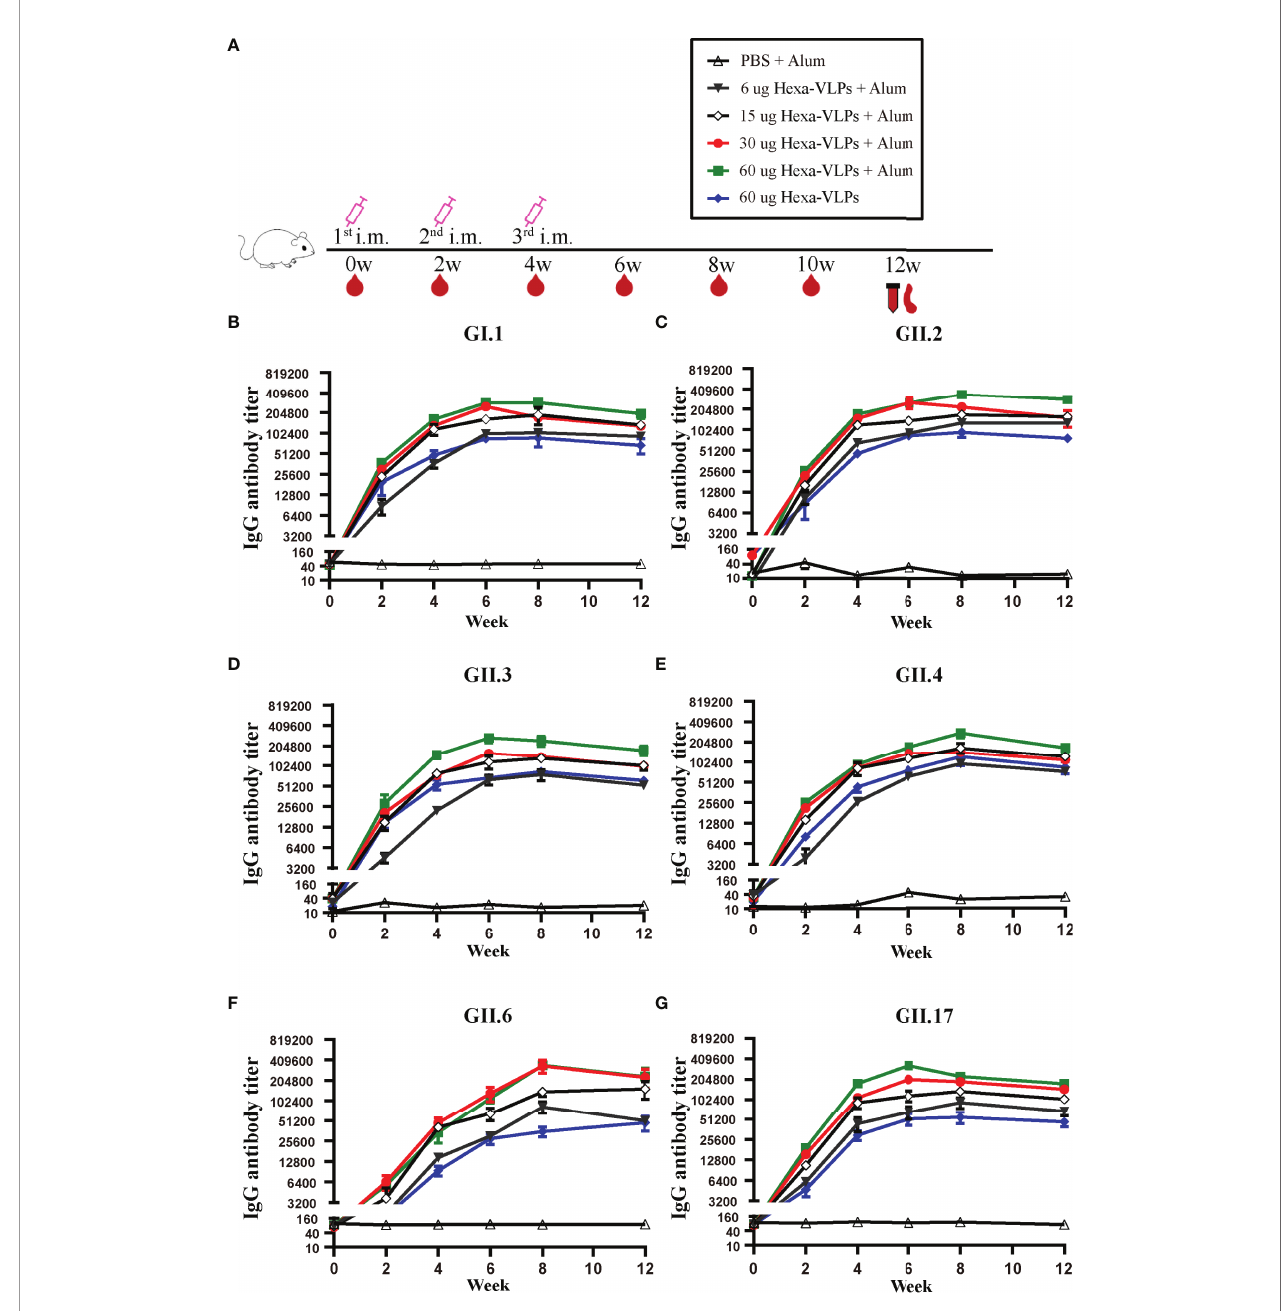
FIGURE 2 | NoV genotype-speci fi c IgG antibody responses induced by diverse Hexa-VLPs dosage. (A) Immunization schemes of the study groups. BALB/c mice (n = 5 per group) were immunized intramuscularly (IM) with PBS, 6 µg, 15 µg, 30 µg, 60 µg Hexa-VLPs with 500 µg alum or 60 µg Hexa-VLPs without alum. Each regimen consisted of three shots at day 0, day 14 and day 28. Blood samples were collected 2 days before each immunization and every 2 weeks after the last inoculation. Binding IgG against (B) GI.1, (C) GII.2, (D) GII.3, (E) GII.4, (F) GII.6 and (G) GII.17 VLPs were detected using ELISA. Sera were 2-fold diluted with an initial dilution of 500-fold, endpoint titers of individual serum were determined as the reciprocal of the highest serum dilution giving an OD450 above the cut-off value. All data were shown as means ± SEM (standard error of mean). Statistical differences at 4 w, 8 w, 12 w were analyzed using one-way analysis of variance (ANOVA) with Tukey ’ s